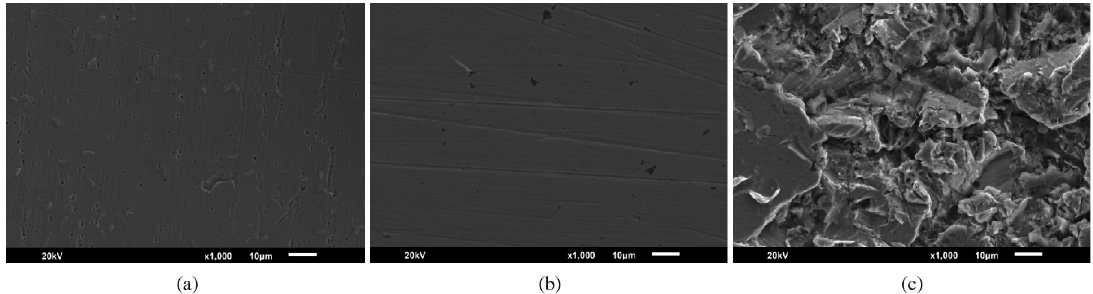
Figure 6. SEM micrographs of the: (a) Bare, (b) Sanded and (c) Shot peening samples , after the EIS test.